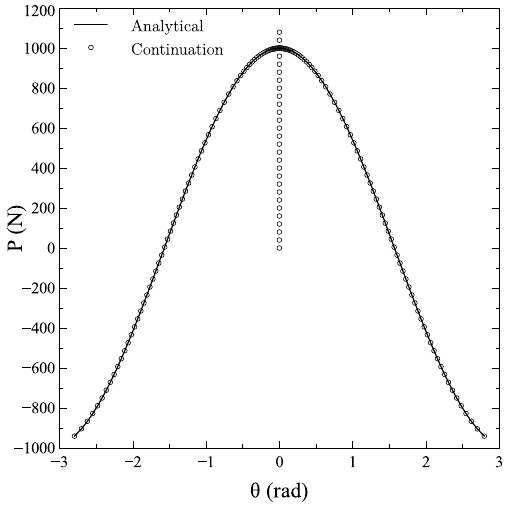
Figure 3. Bifurcation plot for the spring-truss